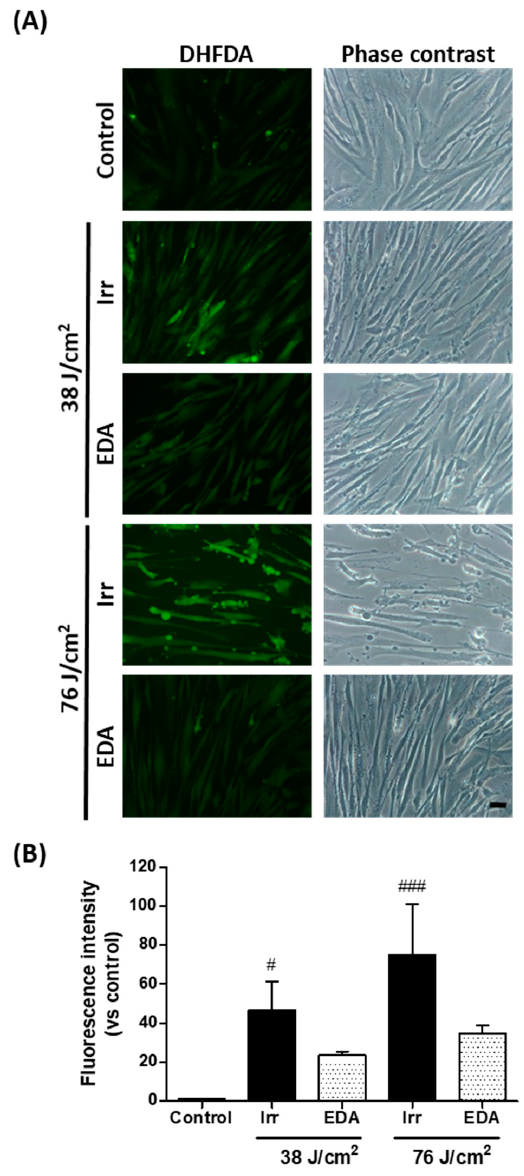
Figure 2. Oxidative stress in human fibroblasts exposed to artificial blue light and EDA pre-treatment. Oxidative stress was evaluated by DHFDA assay. Cells were incubated with EDA 0.1 mg / mL for 24 h, loaded with DHFDA, irradiated at 38 and 76 J / cm 2 , washed and observed under the microscope immediately after irradiation. ROS are evidenced by green fluorescence in HDF exposed to artificial blue light and EDA ( A ). Quantification of DHFDA by fluorescence ( n ≥ 5) ( B ). Data are shown as mean ± SEM. # p < 0.05, ### p < 0.001 vs control. Scale bar: 50 µm.